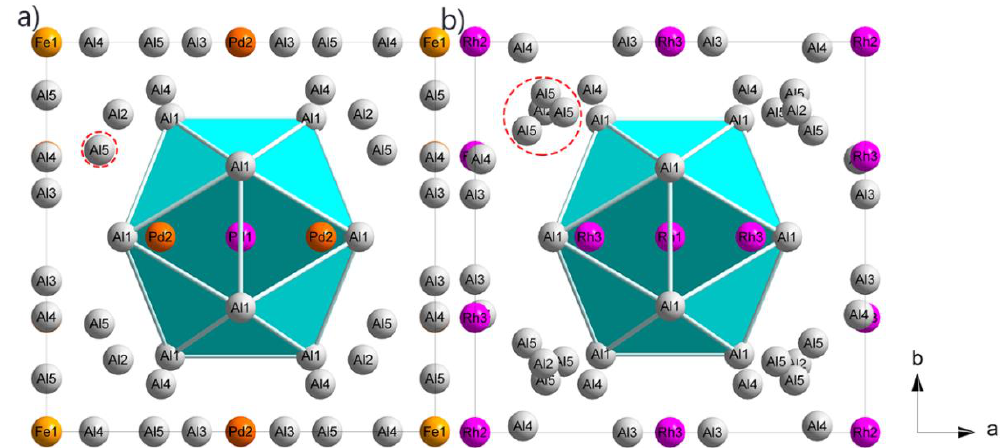
Figure 3. The crystal structure of the C′ -phase ( a ) and the Al 2.63 Rh phase ( b ) projected along the [001] direction. (Graphs prepared by DIAMOND [48]). Table 3. The atomic positions of the C′ -phase (in gray) compared to those of the Al 2.63 Rh phase (Occ. indicates the site occupancy factor).